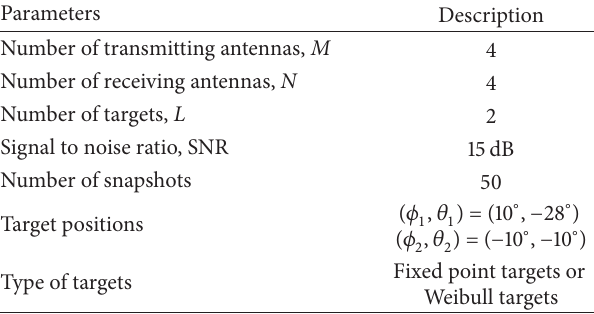
Table 1: Simulation parameters.